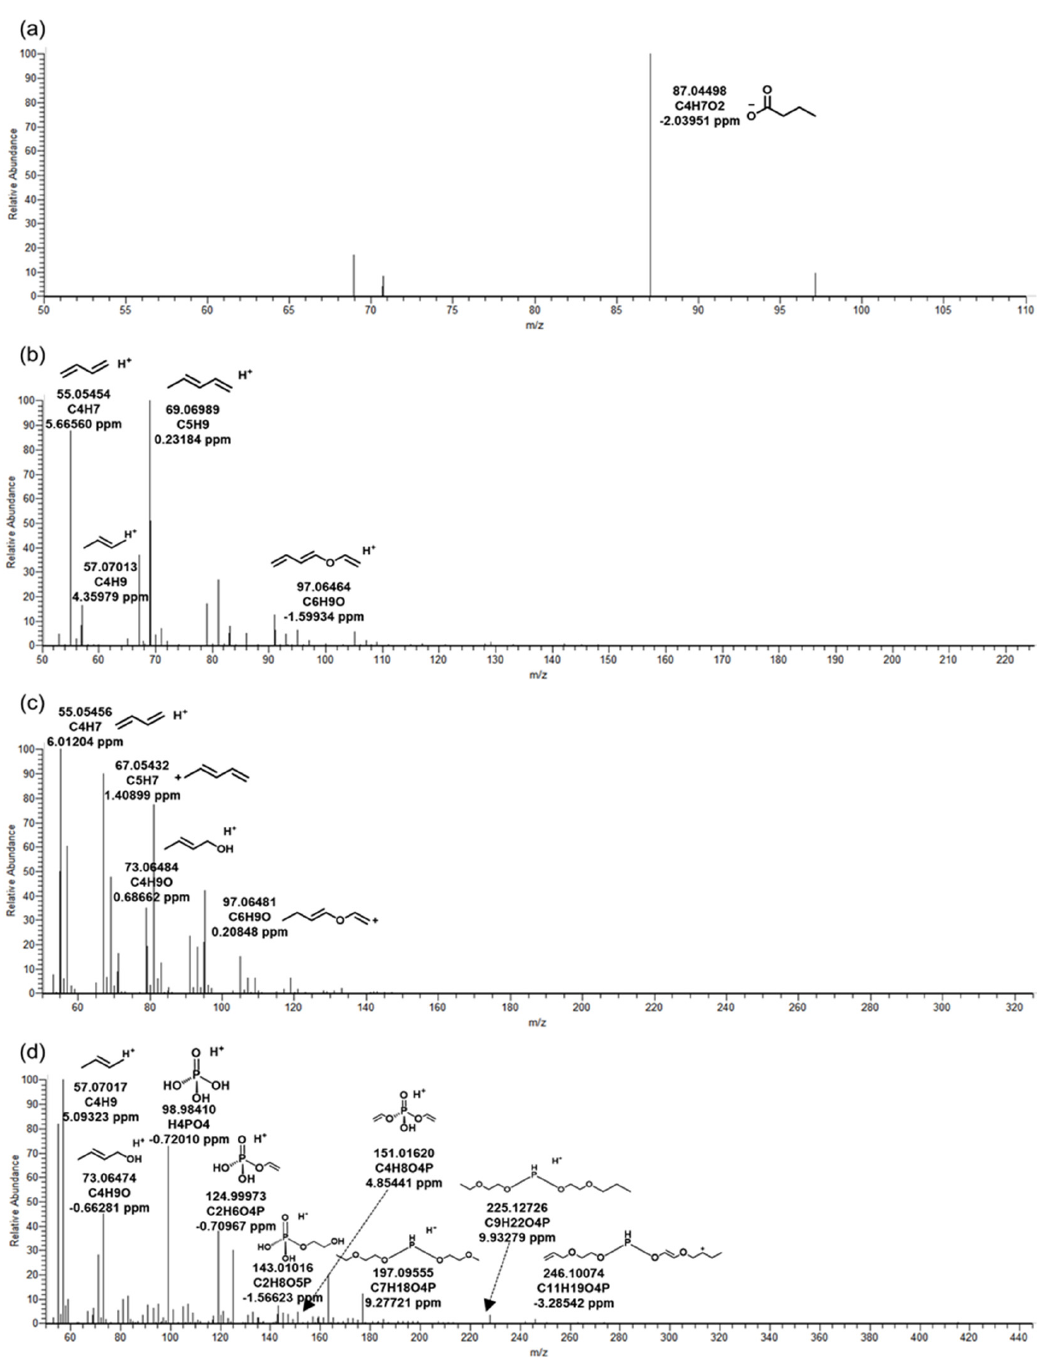
Figure 2. MS/MS fragments of tris (2-butoxyethyl) phosphate in biological reactor of wastewater treatment plant. The biotransformation products: ( a ) TB_88, ( b ) TB_198, ( c ) TB_298, ( d ) TB_412. Table 2. Information on organophosphate flame retardants (OPFRs) and their biotransformation products by microorgan- isms in the wastewater treatment plant (WWTP).